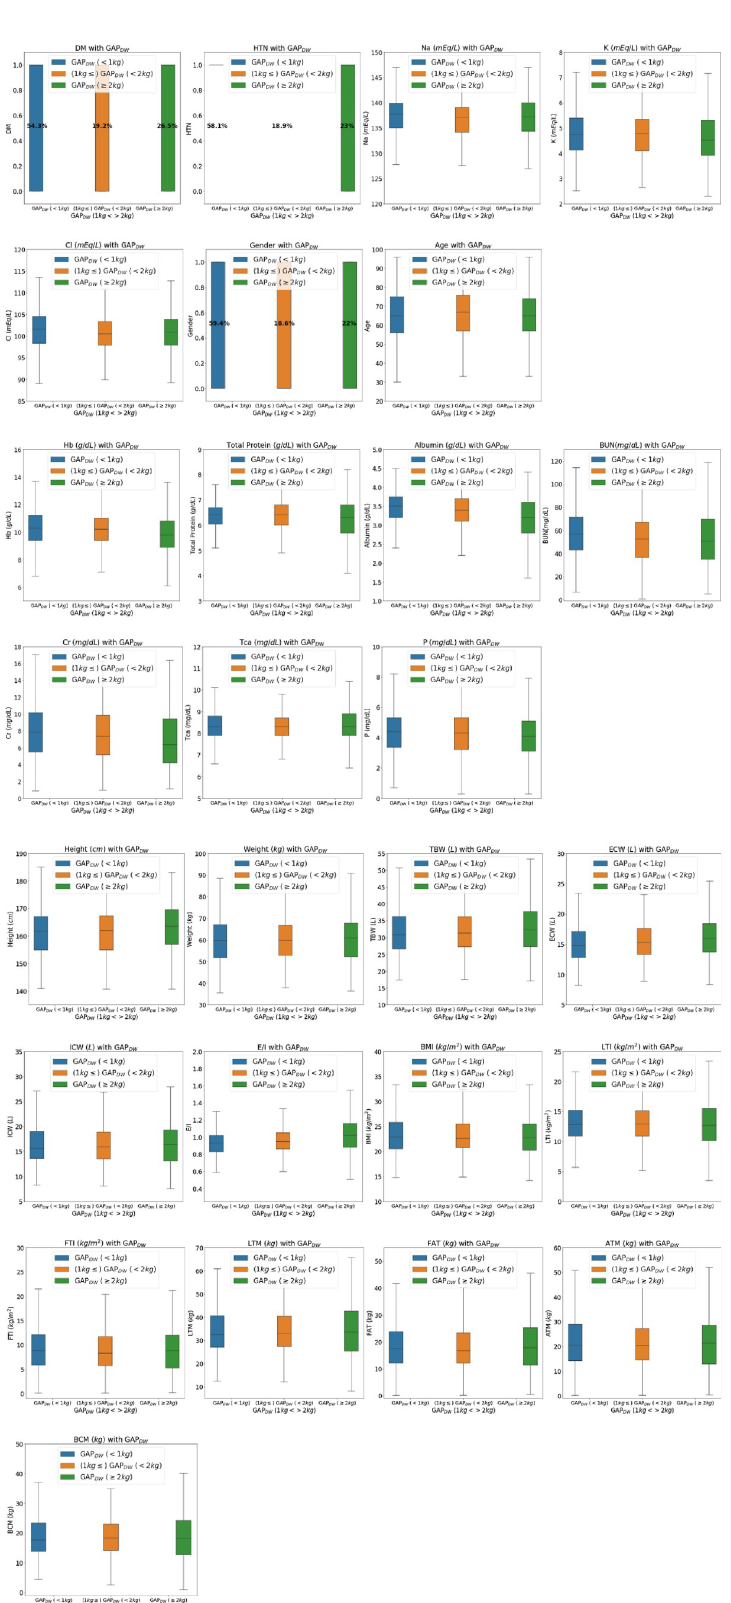
Fig 2. Distribution of the data according to GapDW: (A) clinical data; (B) blood chemistry; and (C) BIS parameters. https://doi.org/10.1371/journal.pone.0250467.g002 PLOS ONE | https://doi.org/10.1371/journal.pone.0250467 April 23,